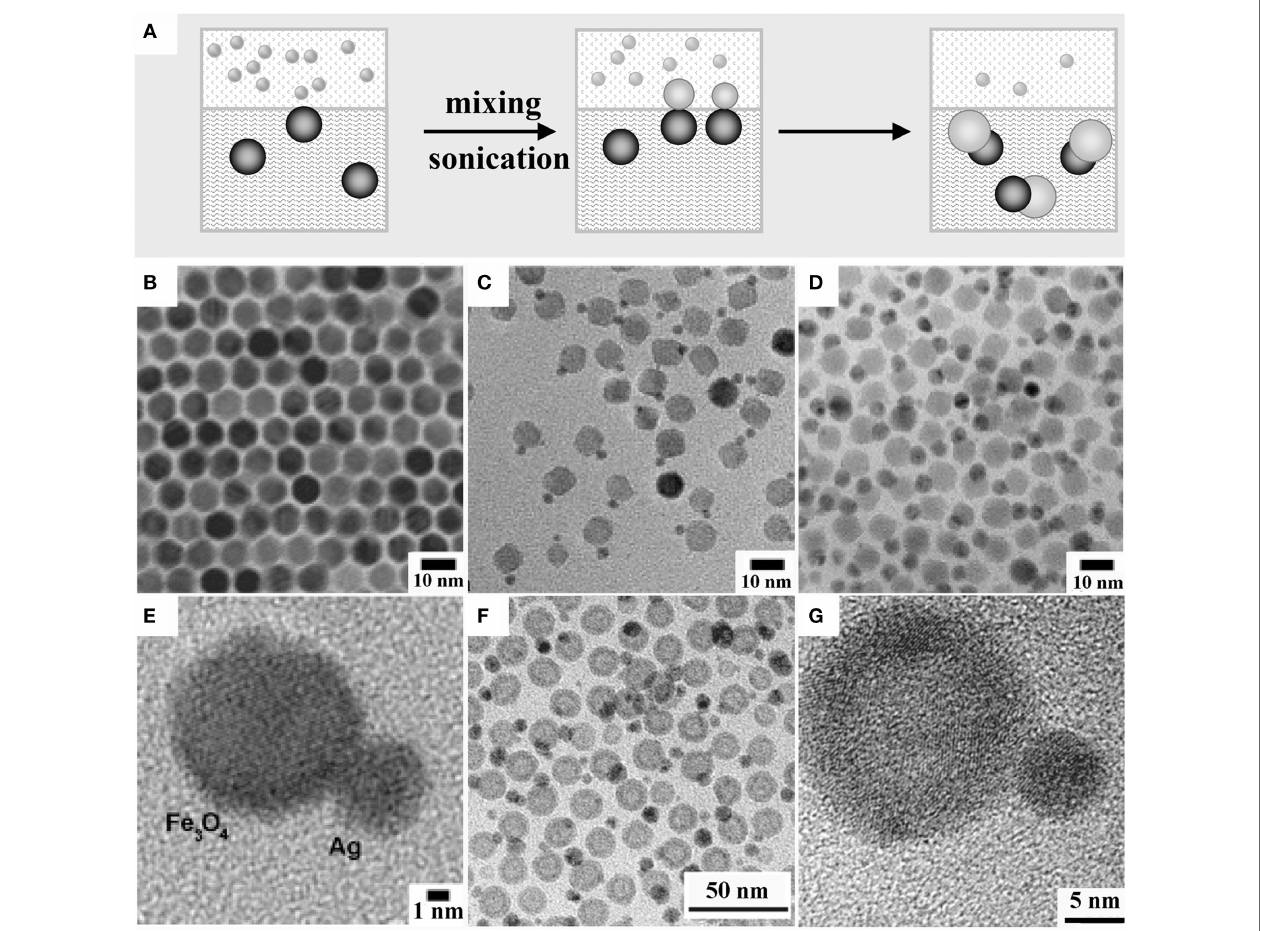
FIGURE 4 | Examples of hetero-dimer magnetic heterostructured nanocrystals (MHNCs) synthesized upon heterogeneous nucleation liquid/liquid interfaces . (A) Sketch of the mechanisms [adapted from Casavola et al. (2008) with permission, copyright Wiley-VCH Verlag GmbH & Co. KGaA]. (A–G) Variable-magnification transmission electron microscopy images of: (B) starting Fe 3 O 4 seeds; (C–E) Fe 3 O 4 –Ag hetero-dimers thereof with different Ag domain size [reproduced from Gu et al. (2005) with permission, copyright American Chemical Society]; (F,G) Fe 3 O 4 –Ag hetero-dimers made of one solid Ag domain and one hollow-Fe 3 O 4 domain [adapted from Pan et al. (2010) with permission, copyright American Chemical